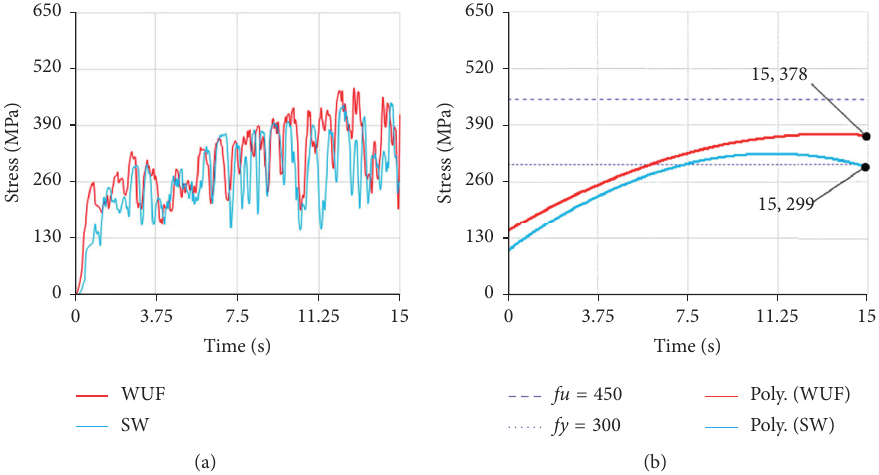
Figure 16: The stress in the connection panel zone (a) and the weld area of the beam to the column connection (b)